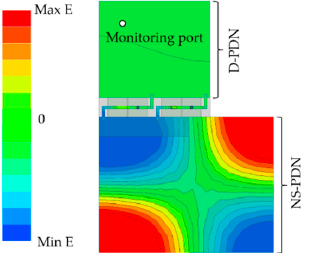
Figure 13. Electric field distribution of the resonant mode (3.37 GHz) that is not seen in the D-PDN.